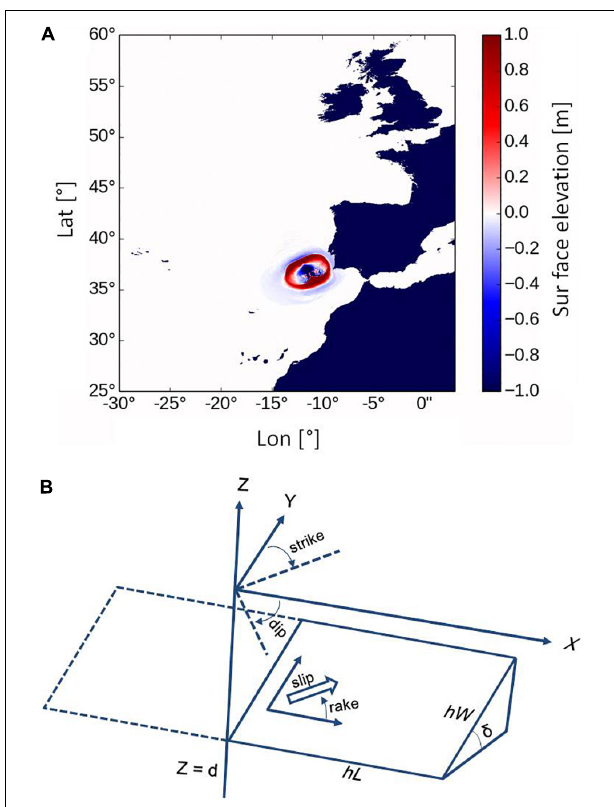
FIGURE 2 | (A) Numerical domain used for the deterministic simulations performed in this study and (B) geometrical input parameters of the tsunami-code employed in the study. d [km] is the depth of the seismic source which is assumed to be at the middle of the fault, hL [km] is the half fault length, W [km] is the half fault width, x-y-z are three-dimensional axes.